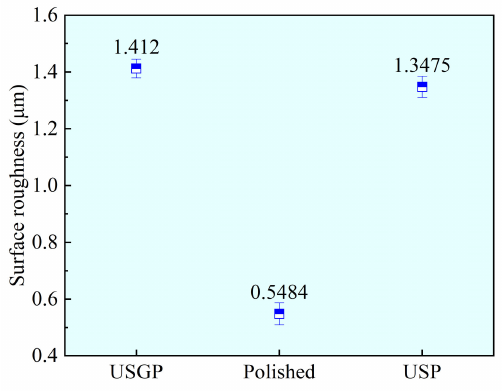
Figure 7. Surface roughness Ra of USGP, polished, and USP